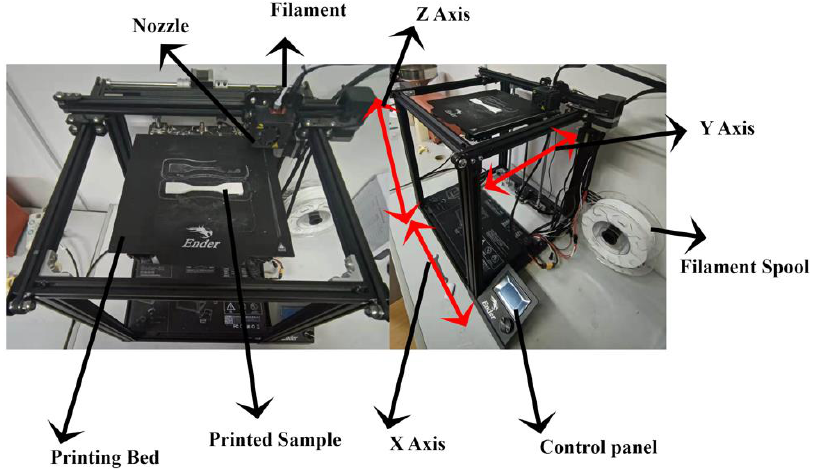
Figure 1. Working of the FFF-based 3D printer.